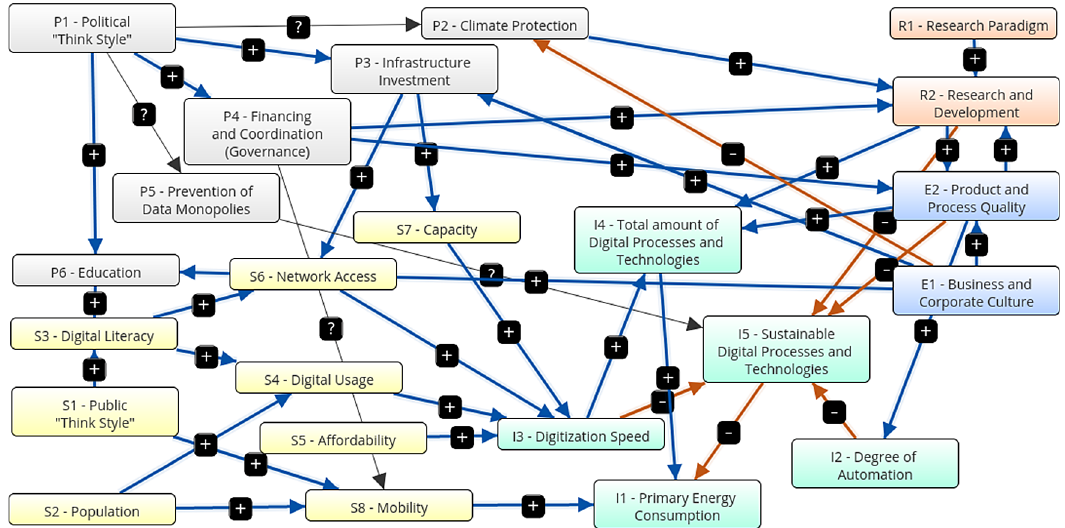
Figure 5. Graphical representation. COVID-19 scenario (Screenshot from Mental Modeler Software).